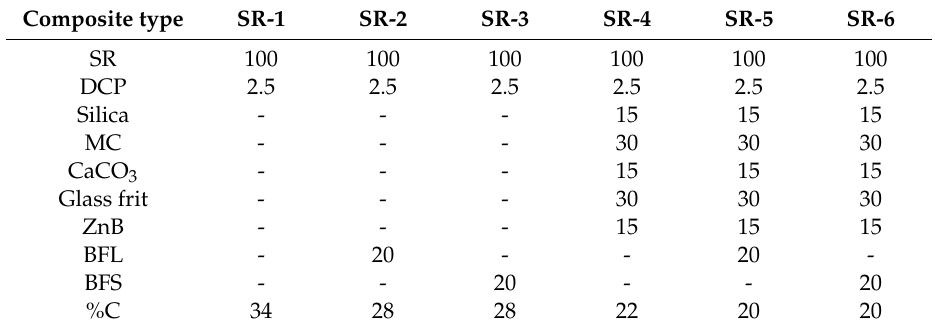
Table 1. Composition (in phr—parts per hundred parts of rubber) of the composite